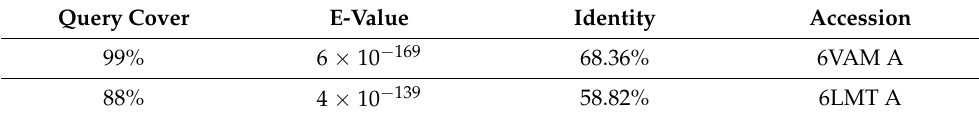
Table 1. CALHM1 BLAST parameters.